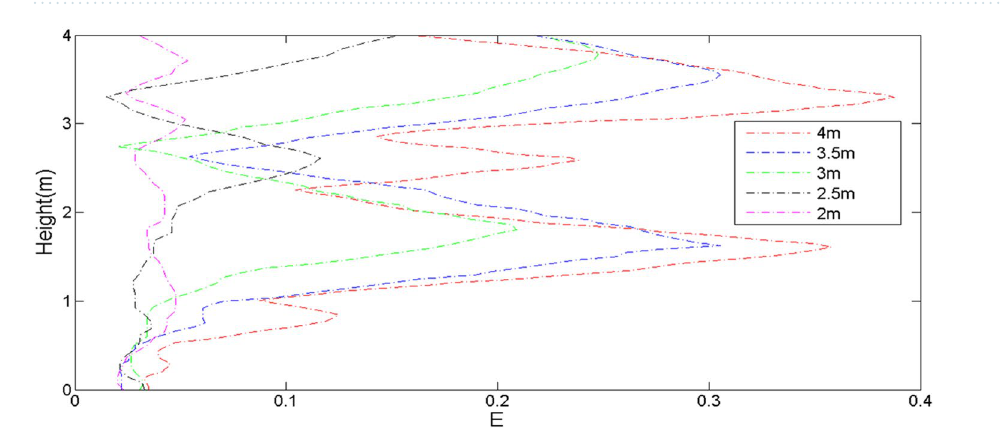
Figure 11. Turbulent intensity at the leeward toe of the sand dunes with different